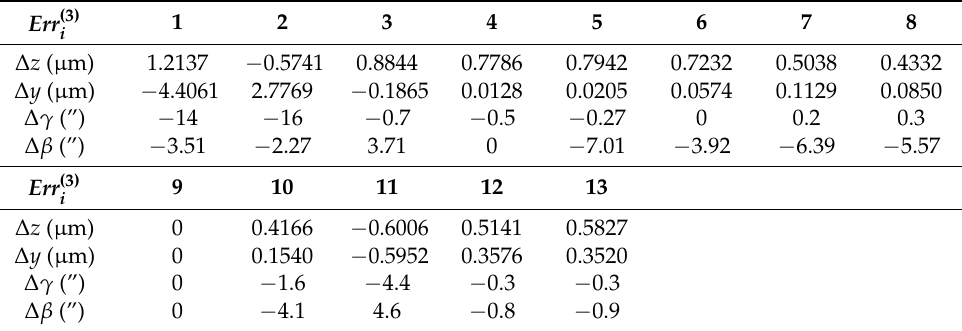
Table 2. The adjustment errors of each sub-aperture for three iterations.